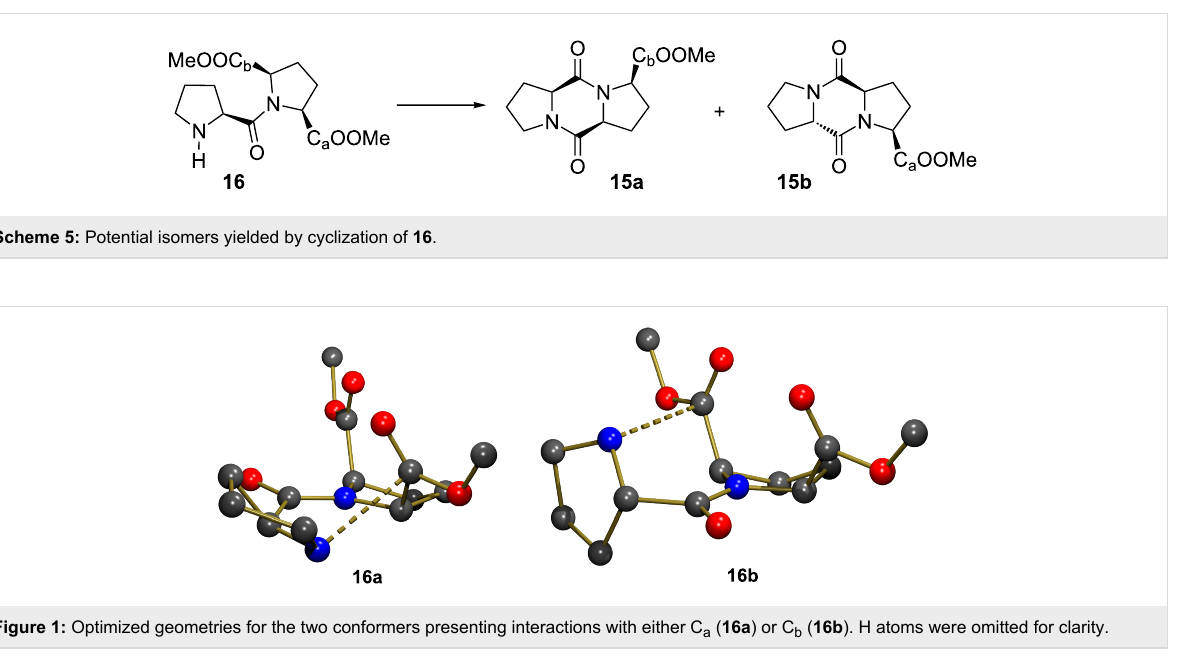
dipeptides 13 and 14 were obtained in good yields (78 and 61%, respectively). Deprotection followed by cyclization provided the corresponding diketopiperazine 15a in 95% yield (from 13 ) or 80% yield (from 14 ). In this case, two carboxymethyl groups could participate in the cyclization providing two possible dia- stereomers 15a and 15b (Scheme